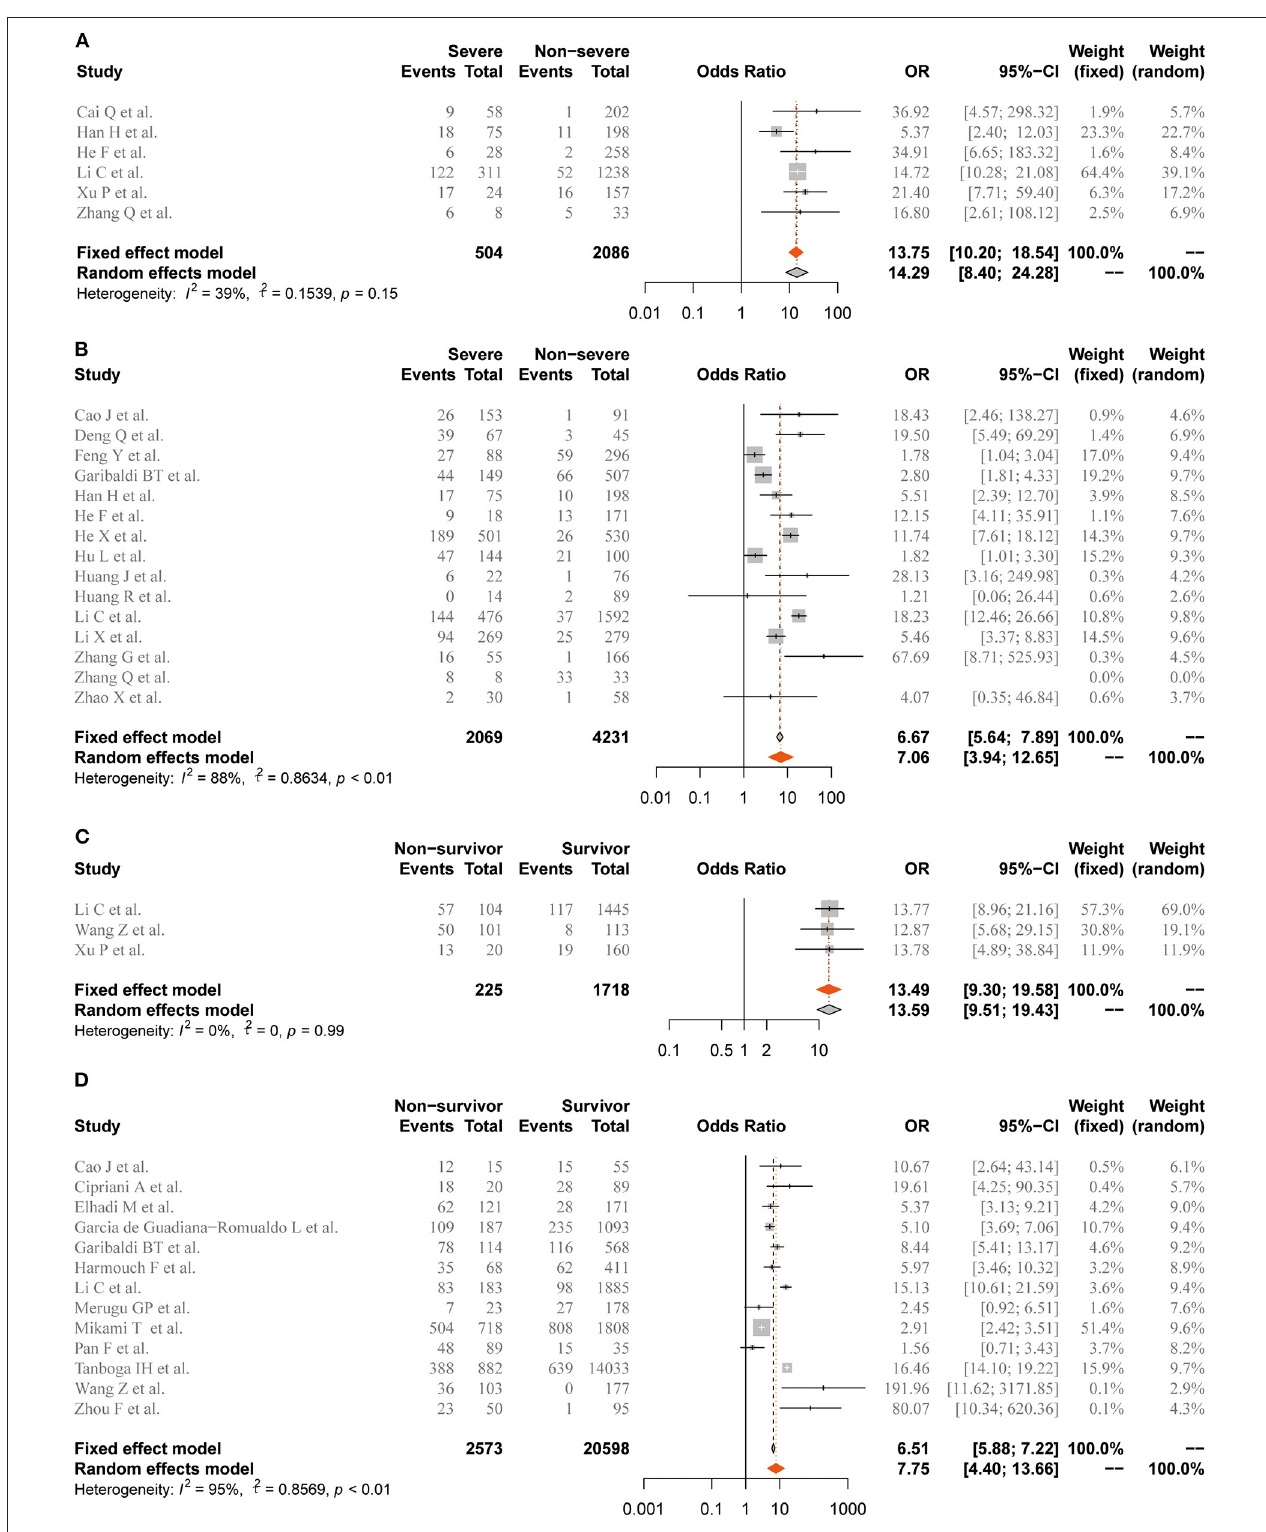
FIGURE 5 | Forest plot for the association of coronavirus disease 2019 (COVID-19)-related adverse outcomes with abnormal level of Mb or cTnI. (A) Severe illness and elevation of Mb. (B) Severe illness and elevation of cTnI. (C) In-hospital mortality and elevation of Mb. (D) In-hospital mortality and elevation of cTnI. Mb, myoglobin; cTnI, cardiac troponin I. Odds ratios (ORs) are presented with fixed-effects when I 2 ≤ 50% and random-effects otherwise.